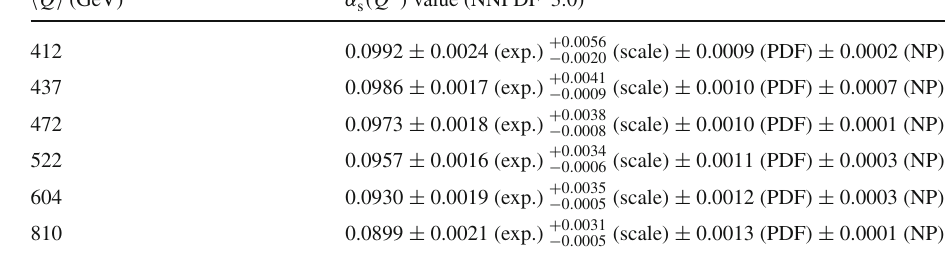
Table 6 Values of the strong coupling constant at the measurement scales, α s ( Q 2 ) obtained from fits to the ATEEC function for each H T2 interval using the NNPDF 3.0